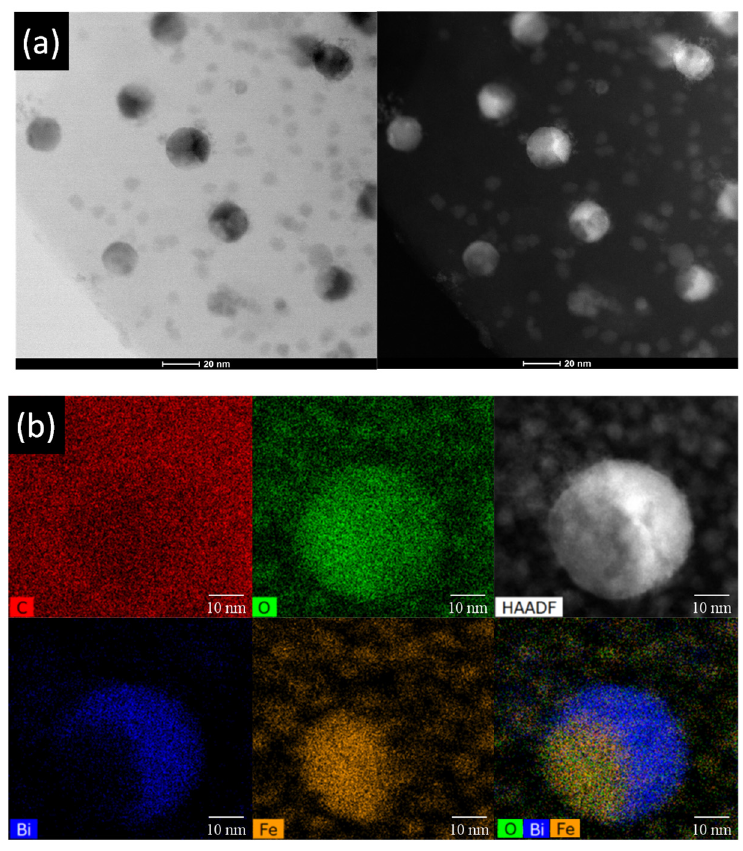
Figure 3. ( a ) BF-STEM and HAADF-STEM images on a large area of the sample containing the hybrid nanoparticles; ( b ) STEM-EDS elemental map and its corresponding HAADF image on a single hybrid nanoparticle showing its chemical composition with bismuth in dark blue, iron in orange, and oxygen in green demonstrated in sample CXBiFe 1.2 .